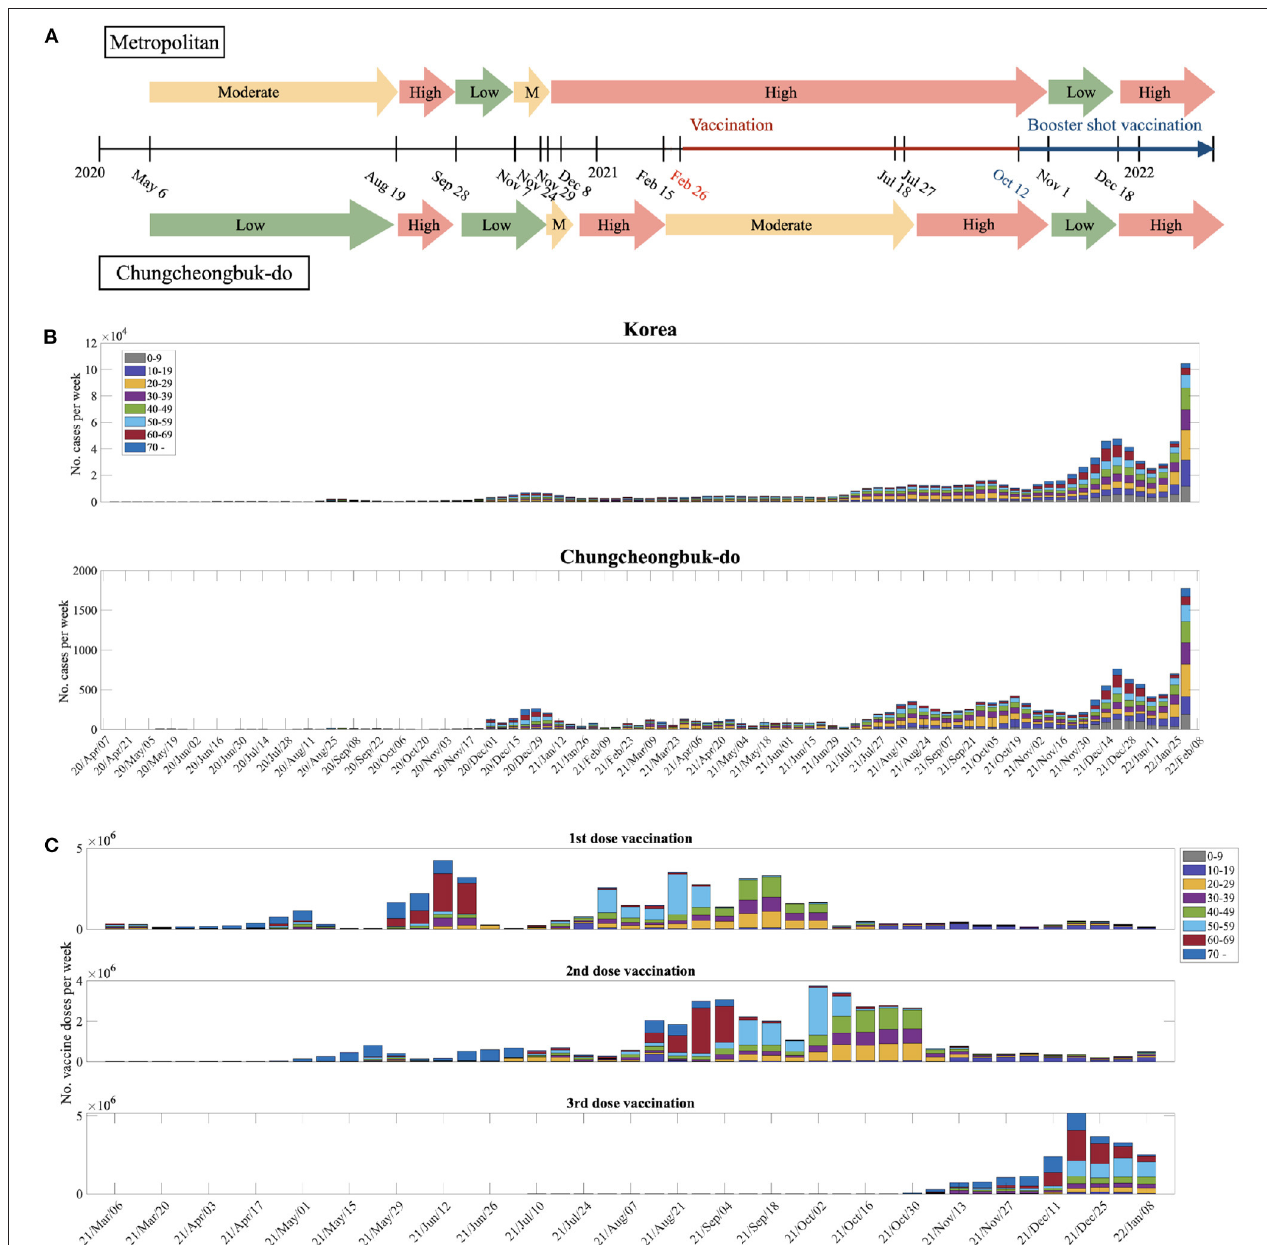
FIGURE 1 | (A) Levels of NPI implemented by the Korean government. (B) Weekly age-specific data of confirmed COVID-19 cases across eight age groups are shown from April 1, 2020, to February 6, 2022. The top panel shows the weekly data of COVID-19 cases in South Korea, whereas the bottom panel shows the weekly data of COVID-19 cases in the CB province. (C) The 1st, 2nd, and 3rd vaccination doses per week for each age group in